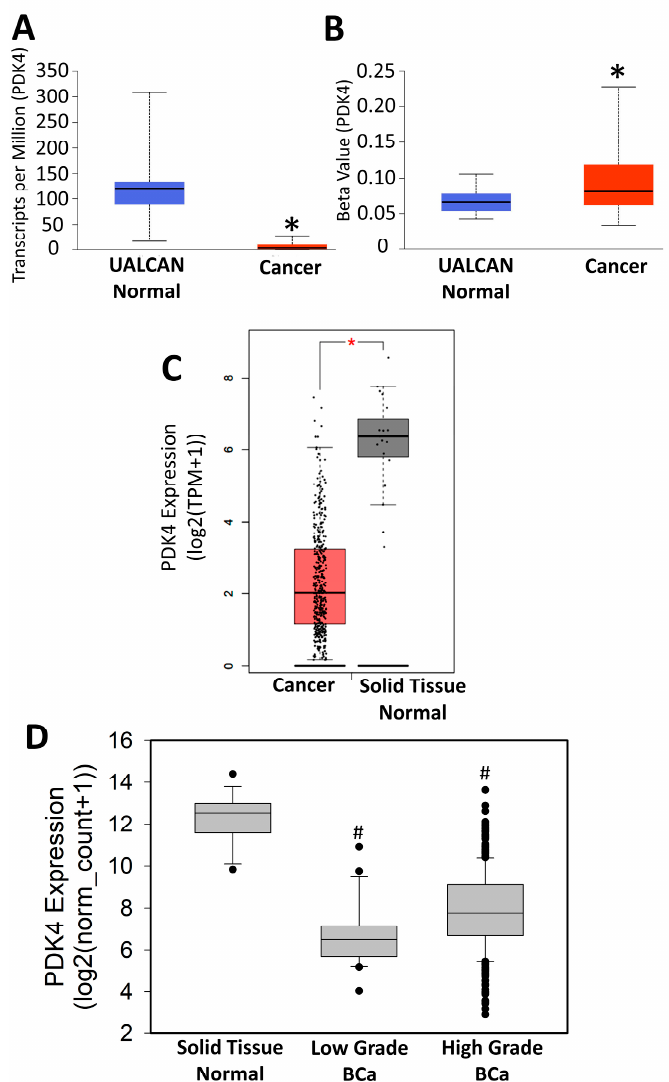
Figure 4. PDK4 gene expression in TCGA. PDK4 gene expression ( A ) (normal n = 19, tumor n = 408) and promoter methylation values ( B ) (normal n = 21, tumor n = 418) acquired via UALCAN. PDK4 gene expression derived from TCGA using GEPIA ( C ) (normal, n = 19; tumor, n = 404) or Xenabrowser ( D ) (normal, n = 19; low grade, n = 21; high grade, n = 383). * p < 0.05 versus solid normal tissue # p < 0.05 versus all other